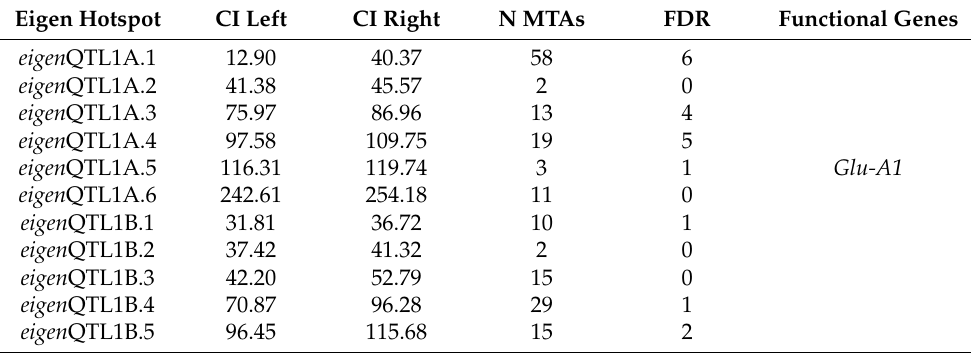
Table 2. QTL hotspots for